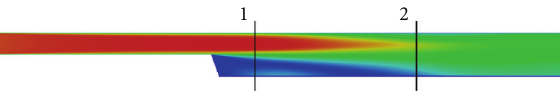
Figure 5: Backward facing step. Control sections.